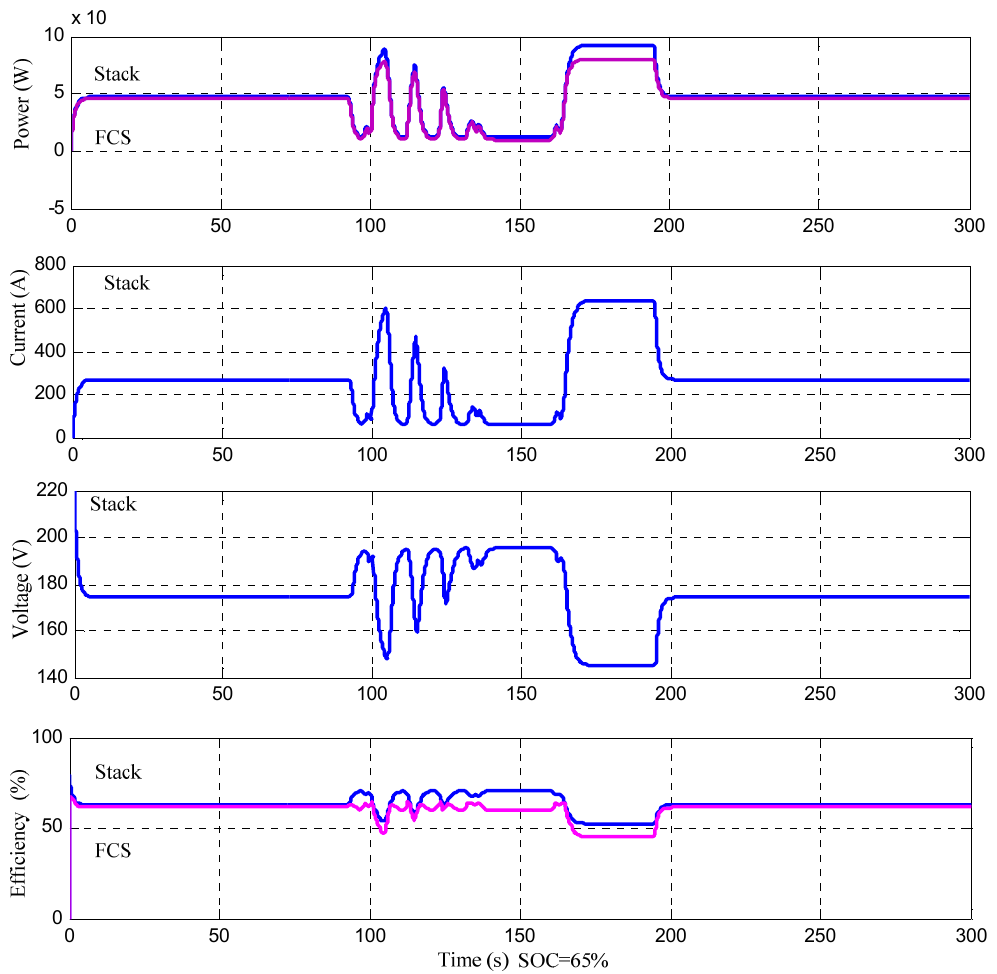
Figure 18. FC characteristics for Case